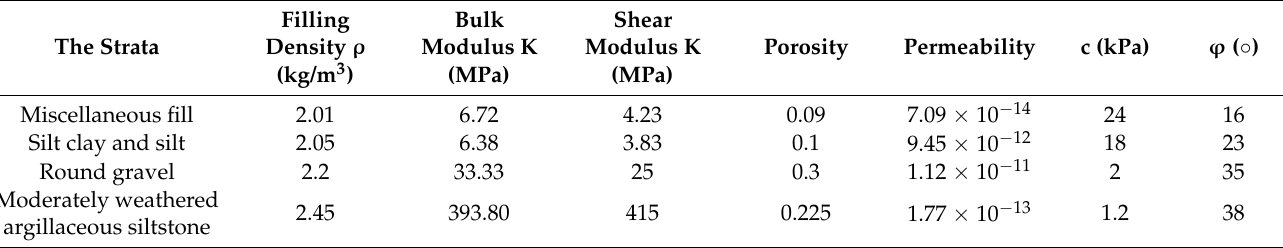
Table 1. The main parameters of the